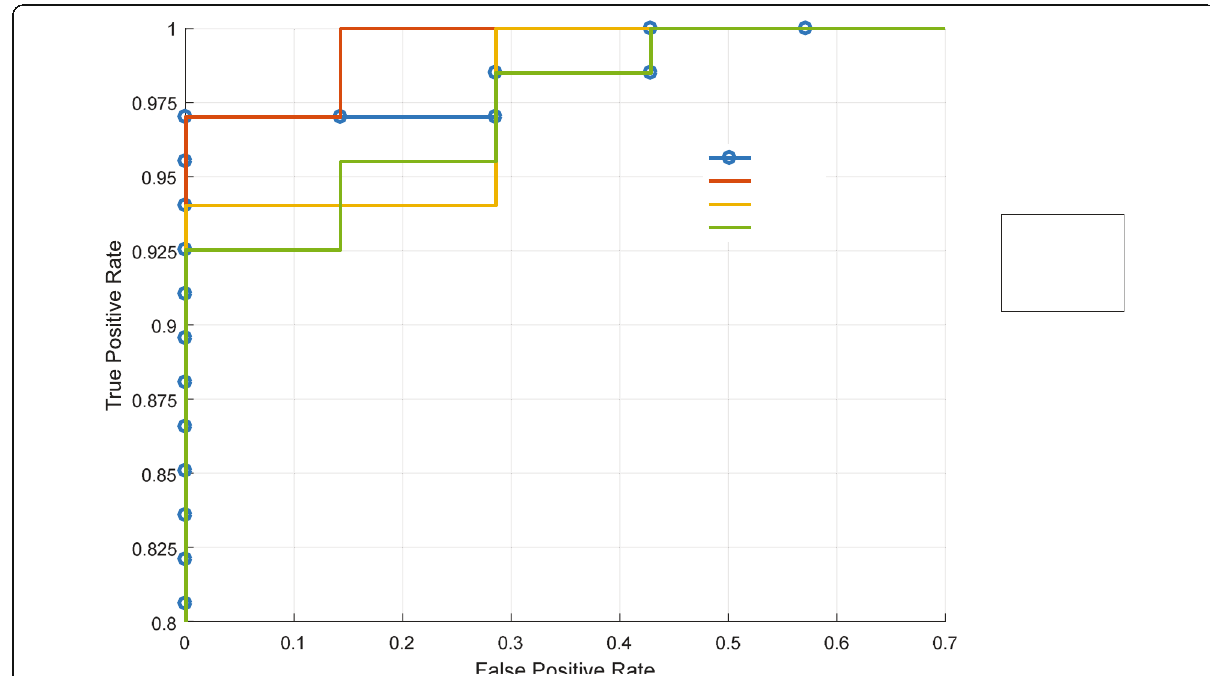
Fig. 10 Quantitative comparison of the detection results from the PETS 2009 dataset using ROC